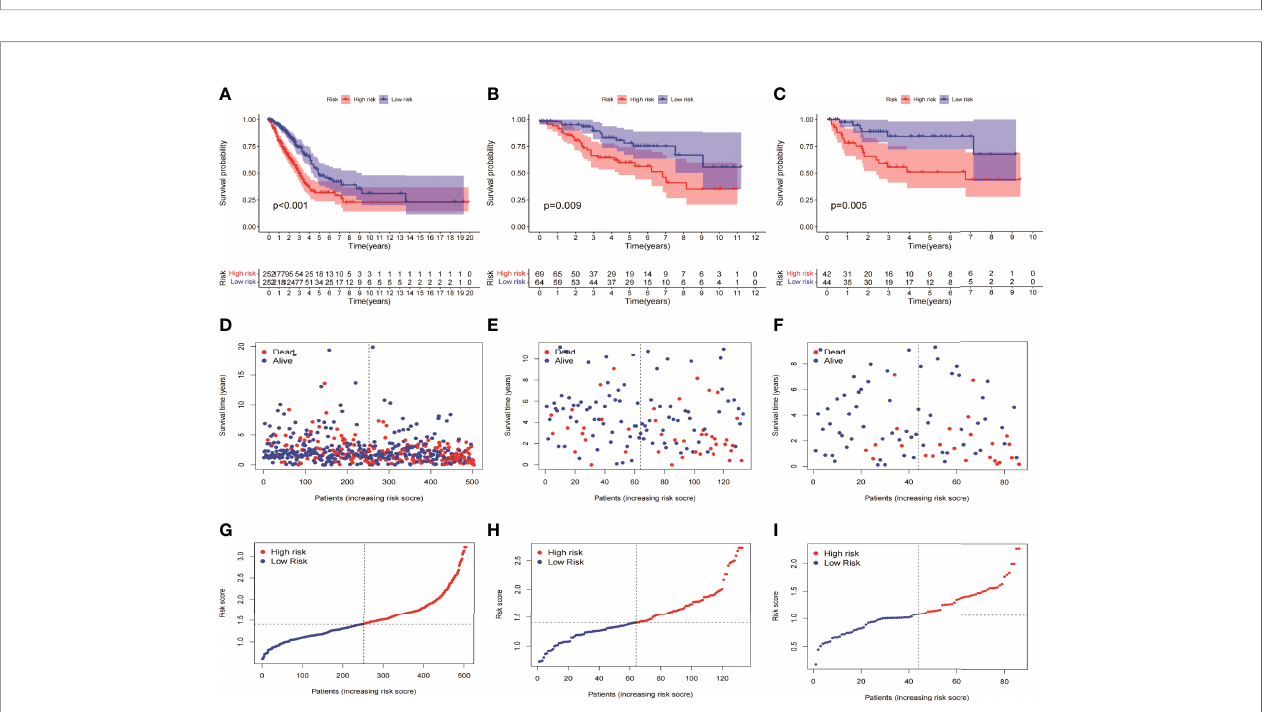
FIGURE 3 | KM survival analysis between the high- and low-risk groups of the model. (A, D, G) TCGA LUAD showed a worse prognosis in the high-risk group than in the low-risk group, with p < 0.001. (B, E, H) GSE42127 showed that the prognosis of the high-risk group was worse than that of the low-risk group ( p = 0.009). (C, F, I) GSE68571 showed that the prognosis of the high-risk group was worse than that of the low-risk group ( p =